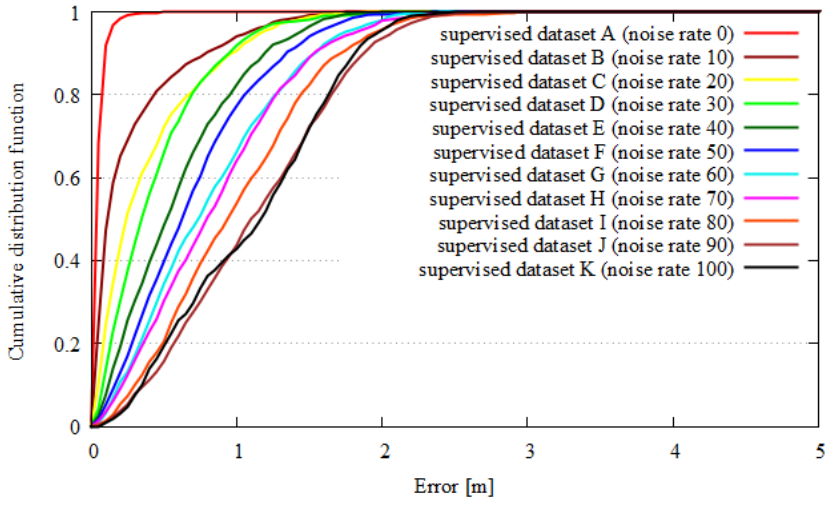
Figure 15. Test error of each dataset in scenario